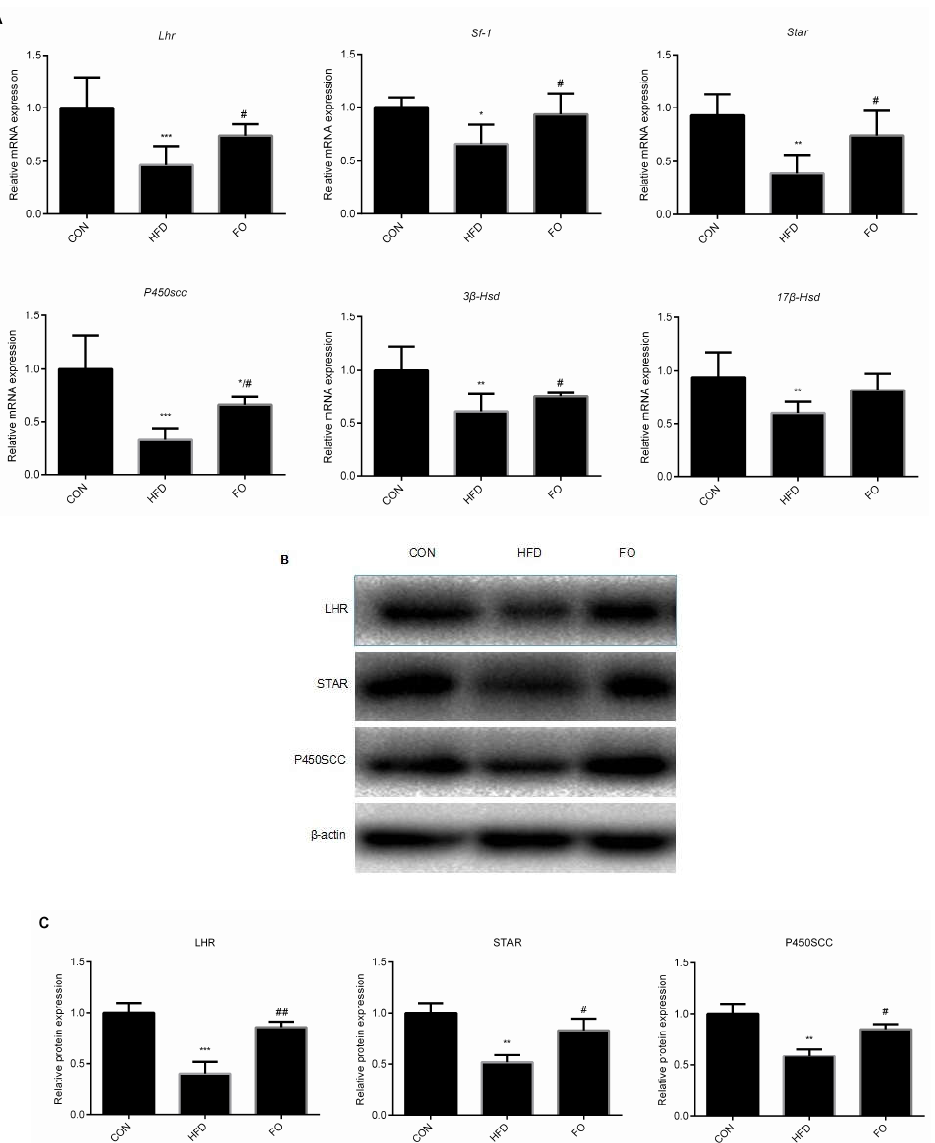
Figure 5. Effect of HFD and FO on the expression of the genes involved in some testosterone synthesis in the testes. ( A ) the mRNA expression of Lhr , Sf-1 , Star , P450scc , 3 β -Hsd , 17 β -Hsd in the testes. ( B ) Western blot analysis of LHR, STAR, P450SCC expression in the testes. ( C ) The LHR, STAR, P450SCC expression levels were quantitatively analyzed with Image Lab software. Data were expressed as mean ± SD ( n = 10 per group). * p < 0.05, ** p < 0.01, *** p < 0.001 vs. CON group; # p < 0.05, ## p < 0.01 vs. HFD group.